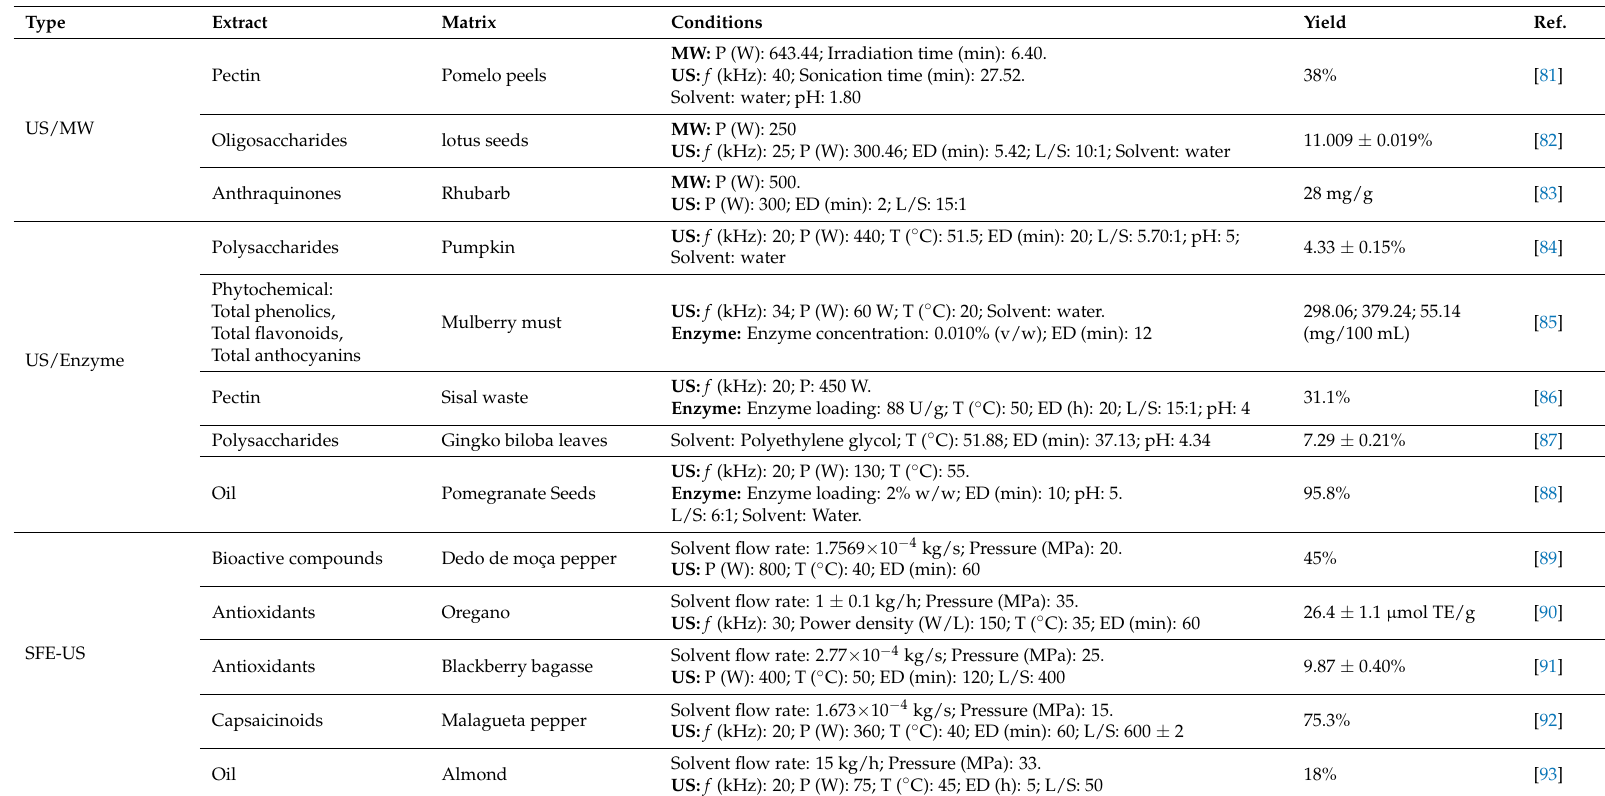
Table 3. UAE based combined